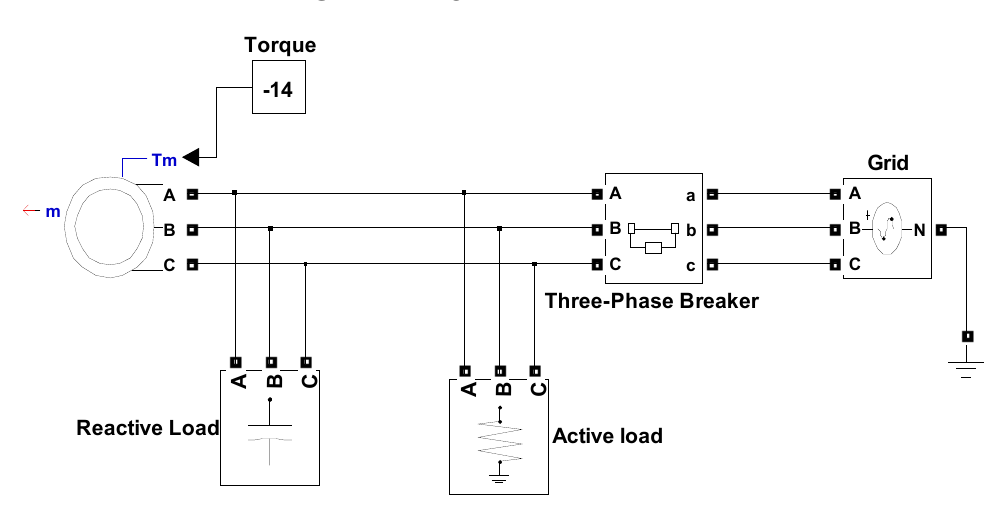
Figure 5. IG grid connected